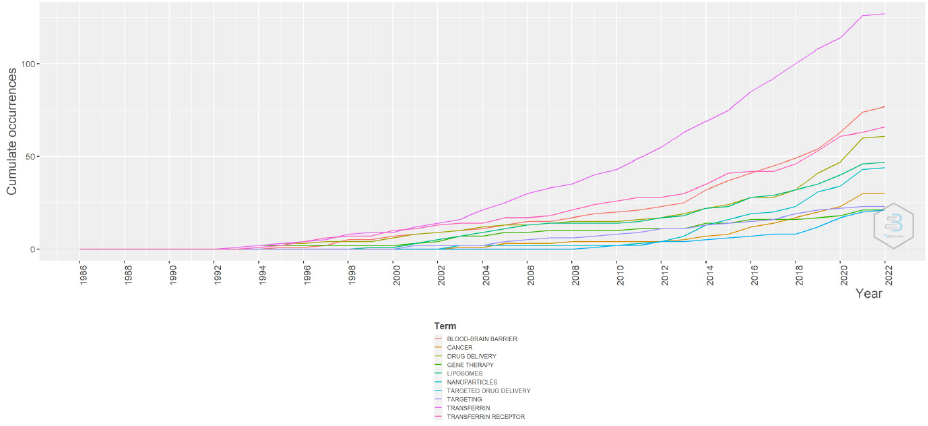
Figure 14. Word growth. Source: Authors’ elaboration using the Bibliometrix R-package.